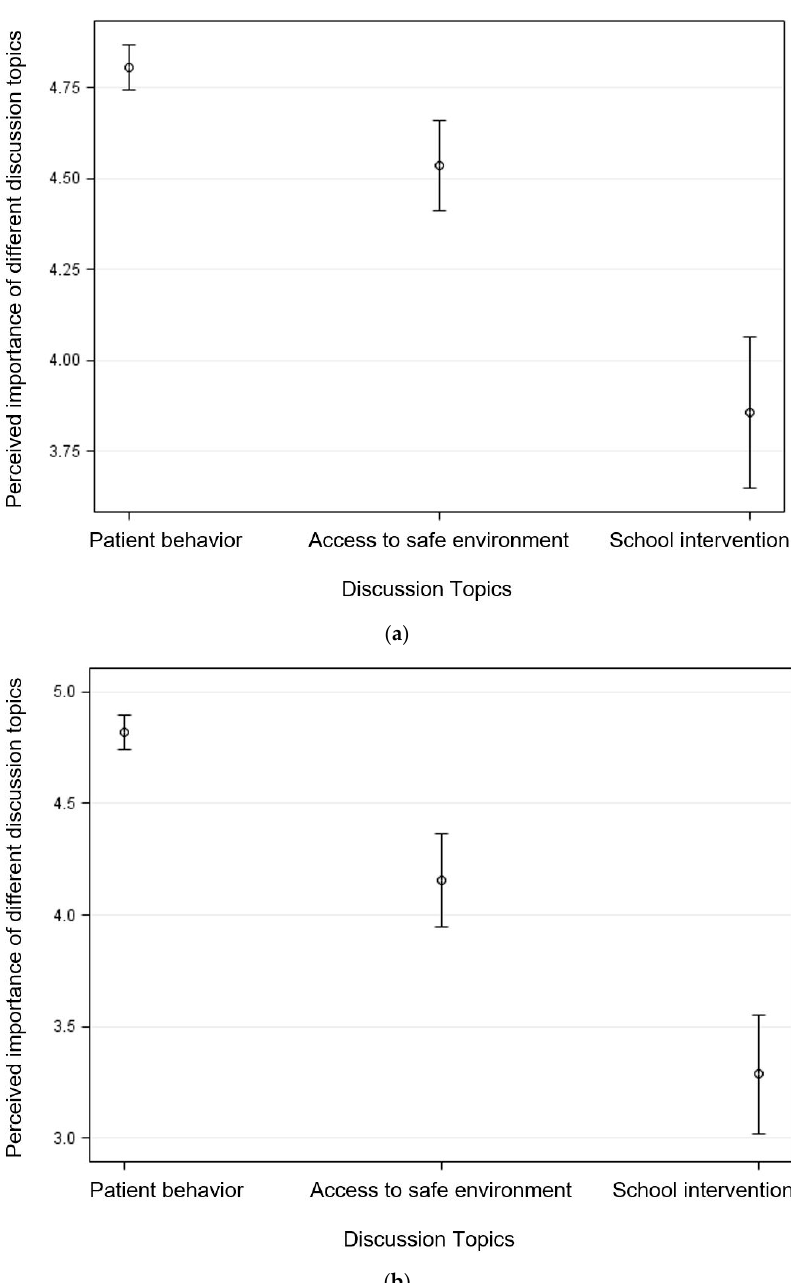
Figure 2. Estimated mean with 95% confidence interval for medical students’ perceived importance of different topics that can be discussed with ( a ) parents and ( b ) child patients (score ranging from 1 to 5, with a higher score indicating greater importance).